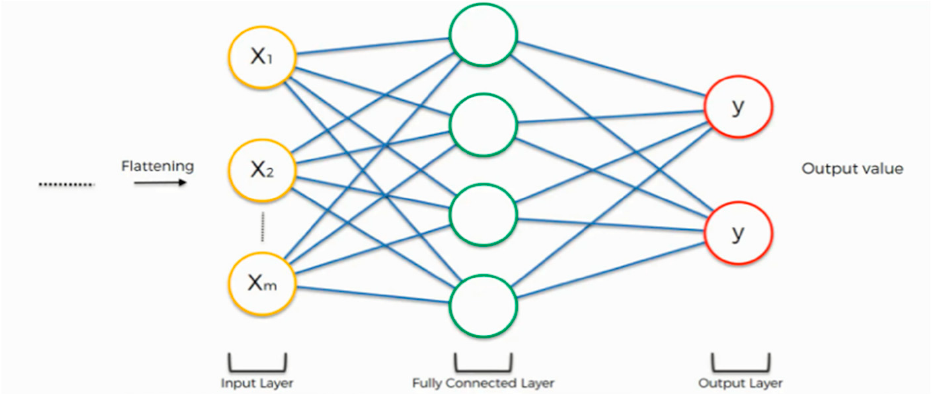
Figure 19. Full connection step—with single neuron output [57].